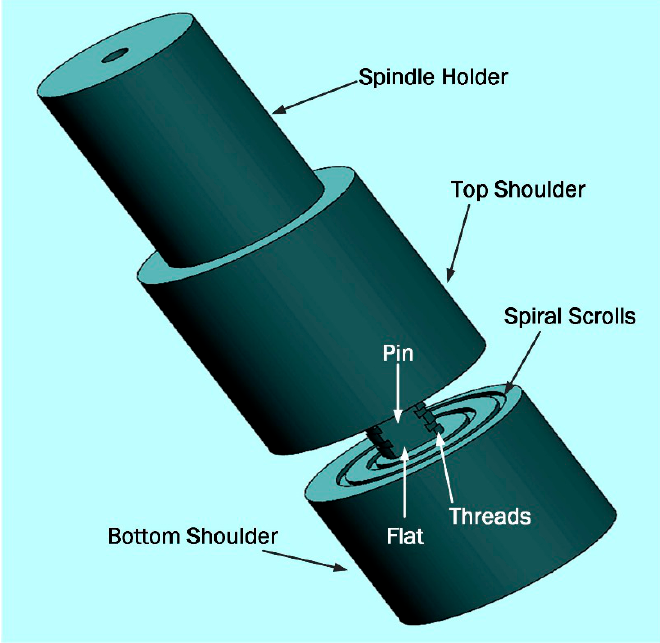
Figure 1. Schematic of the fully-featured Bobbin-Tool (tri-flat threaded pin and spiral scrolled shoulders). Figure1. Schematicofthefully-featuredBobbin-Tool(tri-flatthreadedpinandspiralscrolledshoulders).